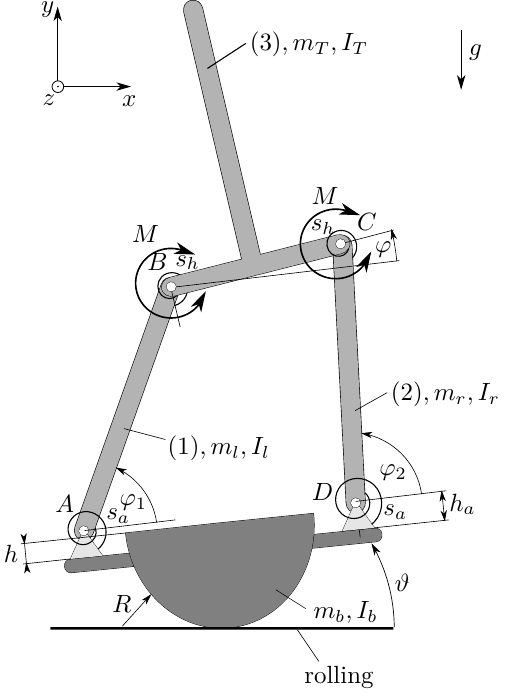
Figure 3. Two-degree-of-freedom mechanical model of balancing on a rolling balance board in the frontal plane.